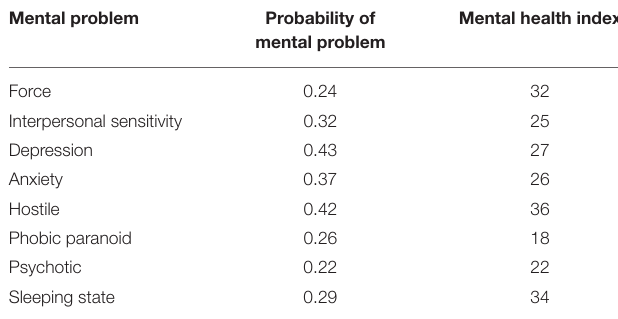
function of mental health level of community workers involved